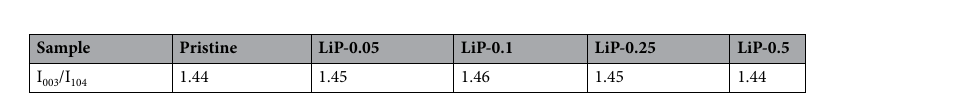
Table 1. I 003 /I 104 ratio of pristine and LiP-NCM cathode samples.